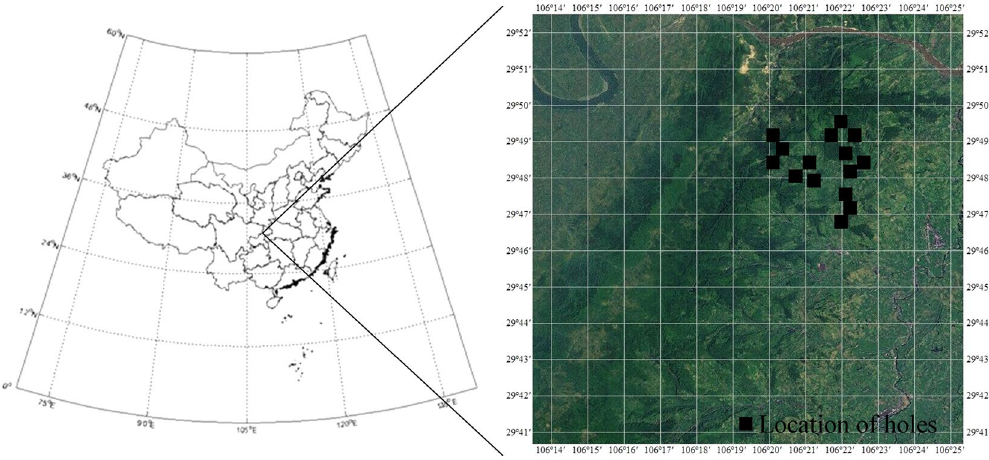
Figure 5. Location of Jinyun Mountain in Chongqing, China. (Left: ArcGIS, Version 9.3. http://www.esri.com/; Right: Google Earth, Version 7.1. http://google-earth.en.softonic.com/. Figure 5 was made by Yunpeng